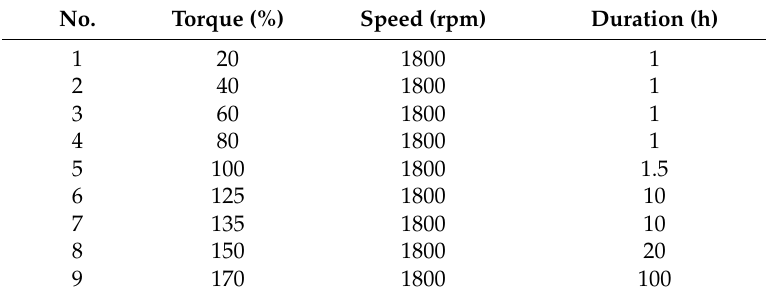
Table 1. Load stage condition.